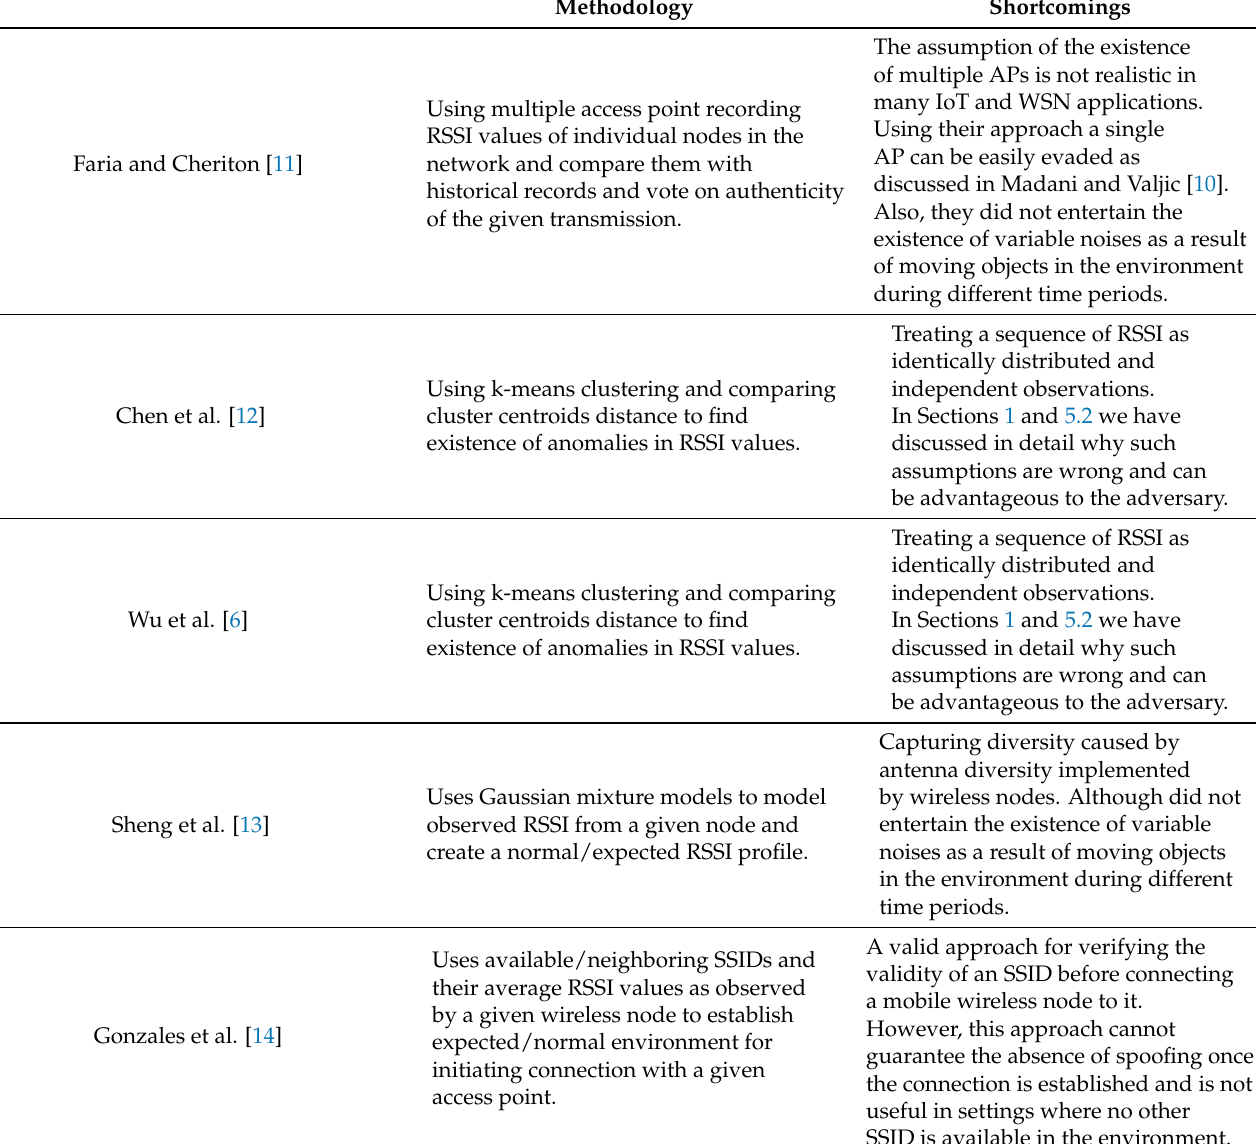
Table 1. Summary of Related